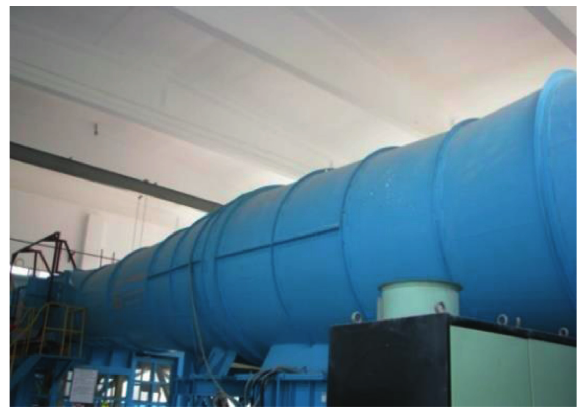
Figure 3: Wind tunnel with low wind speed (1.4m × 1.4 m).